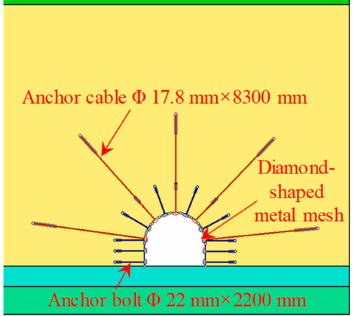
Figure 4. Roadway support plan.